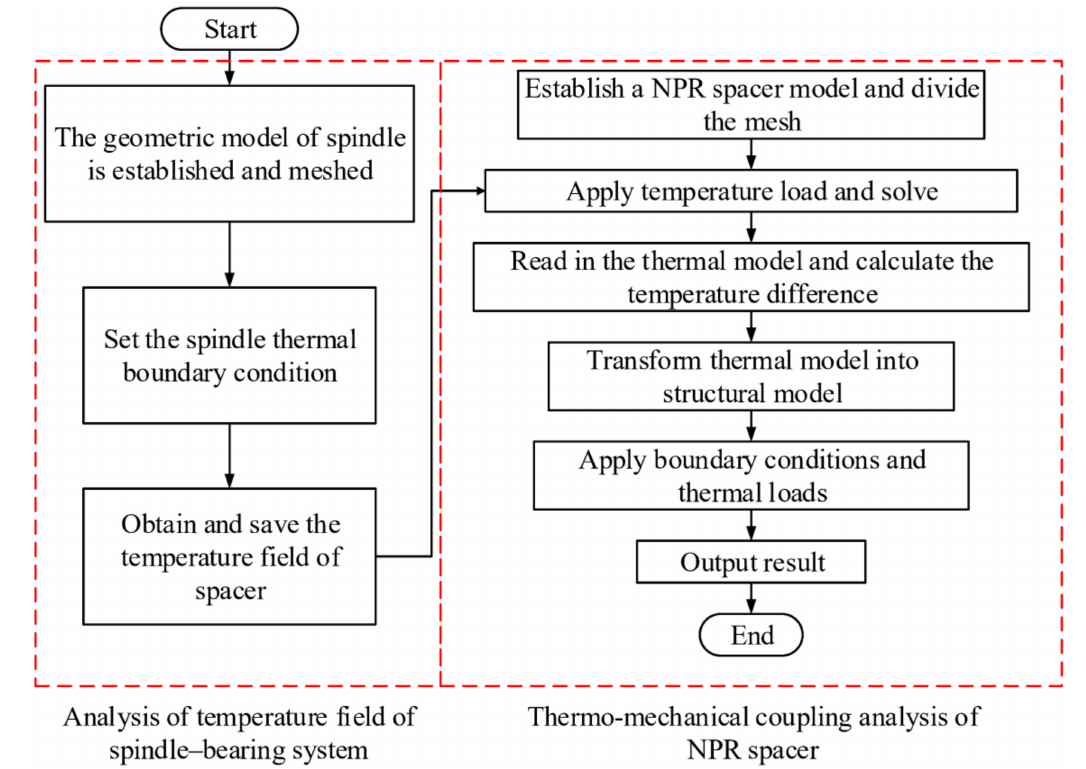
Figure 8. Thermo-mechanical coupling analysis